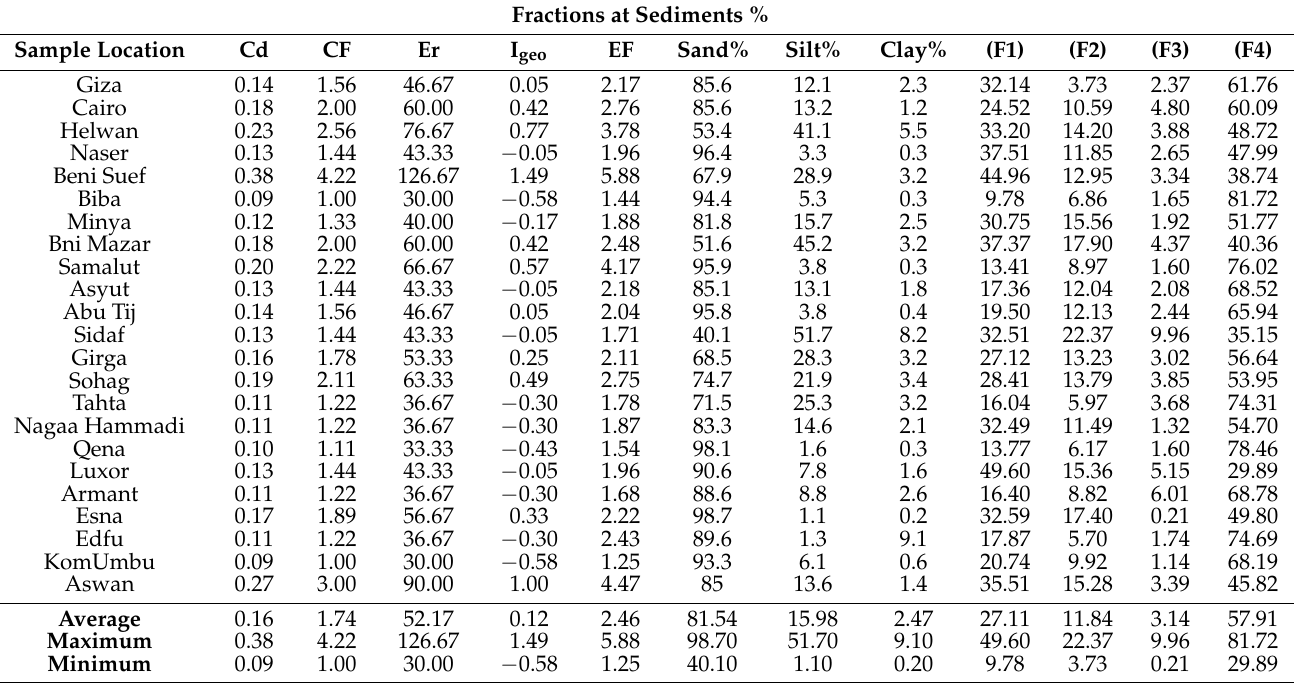
Table 1. The concentration of Cd (mgkg − 1 ), calculated Pollution indices (CF, Er, I geo , and EF), and fractions distributions (%) of Nile River